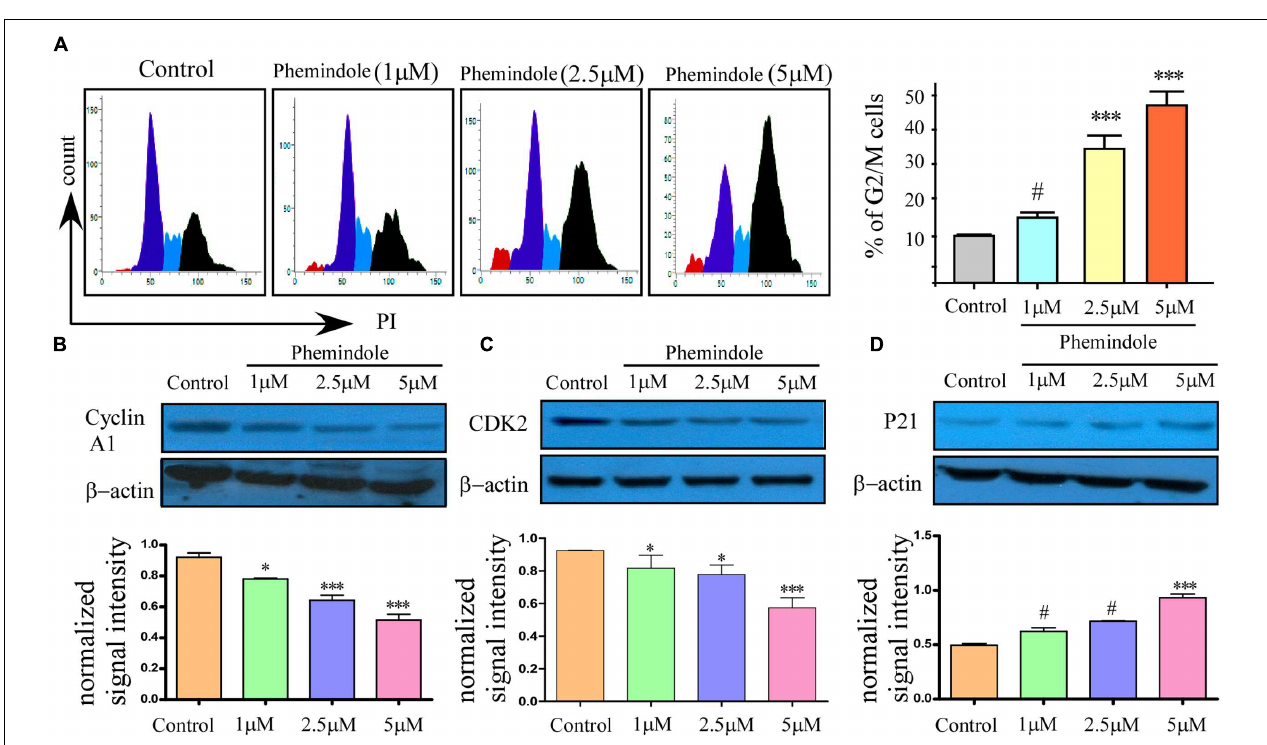
FIGURE 7 | Anti-mitotic property of Phemindole on MDAMB-231 cells. (A) Phemindole induced cell cycle arrest in the G2/M phase in MDA-MB cells. Cells were treated for 24 h with Phemindole at different concentrations as indicated, cells were processed for cell cycle analysis (left panel). Quantified Graphical plot on the right panel. (B–D) Western blot analysis was performed to check the expression of cell cycle-associated proteins in presence of Phemindole in different concentration; β -actin was used as a loading control. Quantification of band intensity in respect to loading control was shown in bar diagram (lower panels). Blots are representative of three independent experiments and quantifications are indicated by bar diagram. Values were normalized by intensity of loading control. ∗ , ∗∗ , ∗∗∗ , # indicate p < 0.05, p < 0.01, p < 0.0005, p > 0.05 respectively versus untreated or control